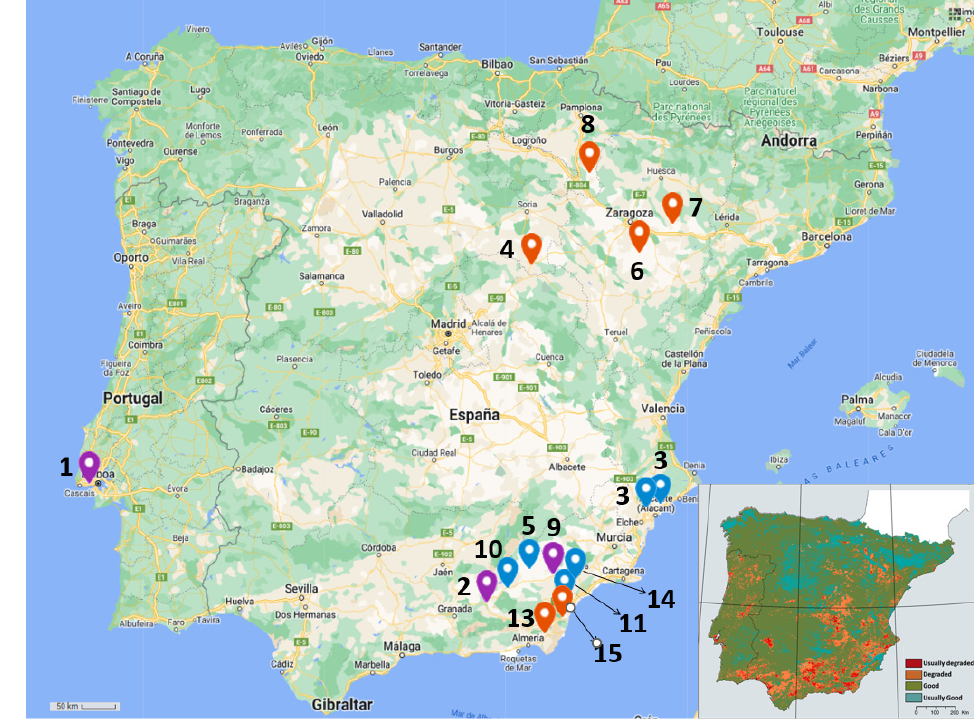
Figure 1. Sampling locations. The upper map (prepared in My Maps, Google) shows the location selected for sampling. Numbers refer to Table 1 sample denomination. Location pins in red indicate samples of alfalfa ( Medicago sativa ); blue pins, samples of pitch clover ( Bituminaria bituminosa ); and violet pins, samples of both types of model plants. Lower-right map indicates risk of degradation by desertification (modified from del Barrio et al., 2010) [59]. Here, red-colored areas indicate land that is usually degraded; orange, land that is degraded; green, land that is in good condition; and blue, land that usually has no risk or is usually in good